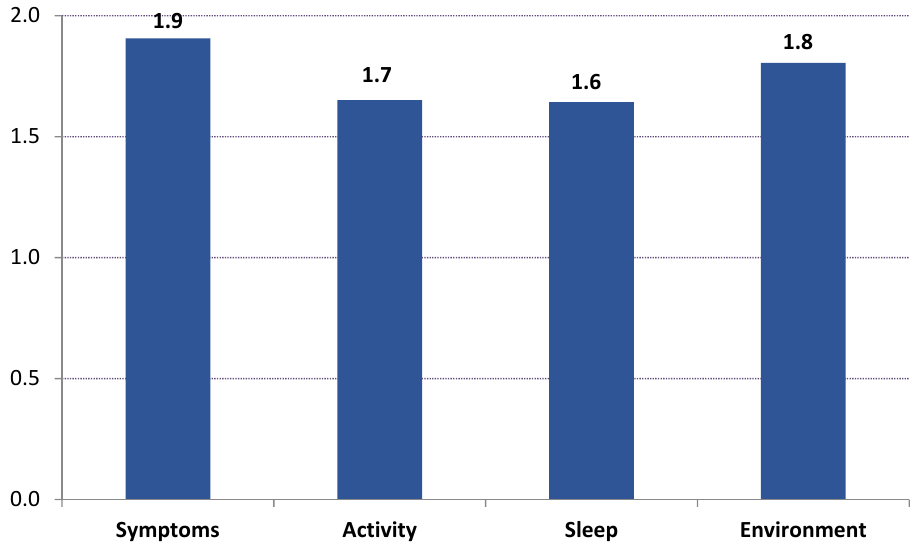
Figure 3. Mean values of the differences between Visit 1 and Visit 3 (Visit 3 minus Visit 1 values) for each AQLQ Domain.